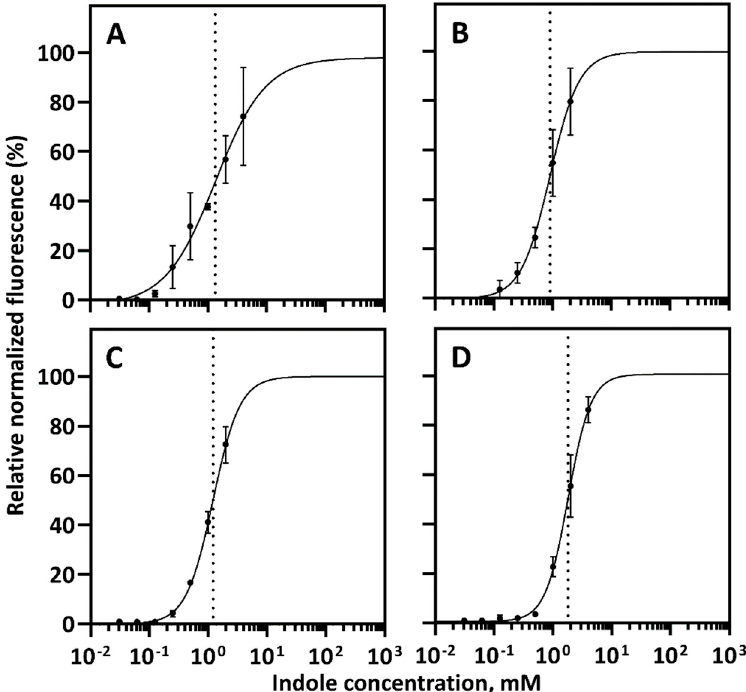
Figure 3. Characterization of inducible system Pp TrpI/P PP_RS00425 -based biosensors in response to different concentrations of indole. The E. coli ( A , C ) and C. necator ( B , D ) biosensor responses were evaluated in MM ( A , B ) or LB medium ( C , D ) 4 h after extracellular addition of indole. The dose-responses were fitted using the Hill function (for more details see Section 4). The maximum reporter output b max was set to 100%. The inducer concentration that mediates half-maximal reporter output K m is indicated by a dotted line. Data are mean ± SD, n = 3.